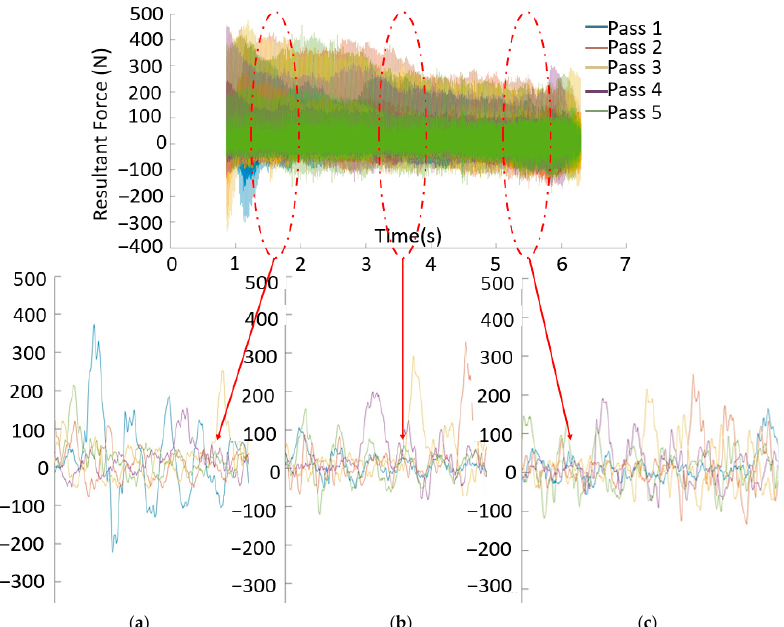
Figure 8. Evaluation of the resultant forces for the time intervals of ( a ) 1.12 to 1.13 s; ( b ) 3.52 to 3.53 s; ( c ) 5.45 and 5.46 s for case number 4.